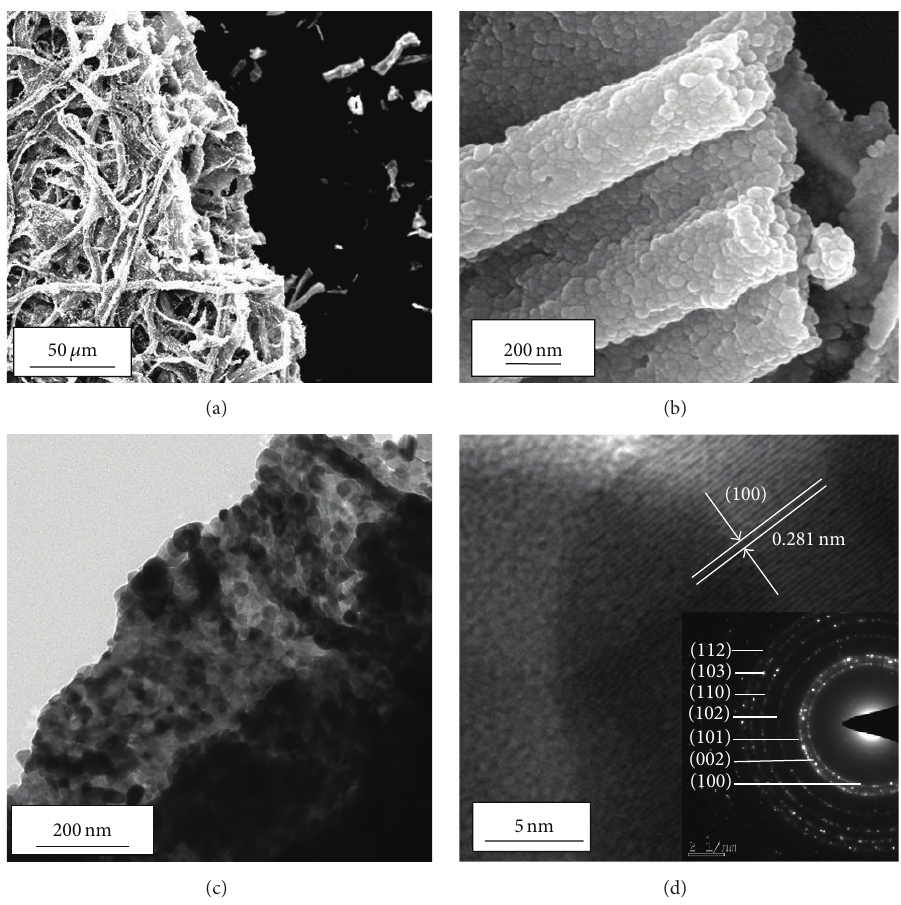
Figure 2: Micromorphology observation of prepared zinc oxide nanomaterials. (a) FE-SEM image, (b) further magnified SEM image, (c) typical TEM image of zinc oxide nanosheet, and (d) HR-TEM image and SAED pattern (insert).